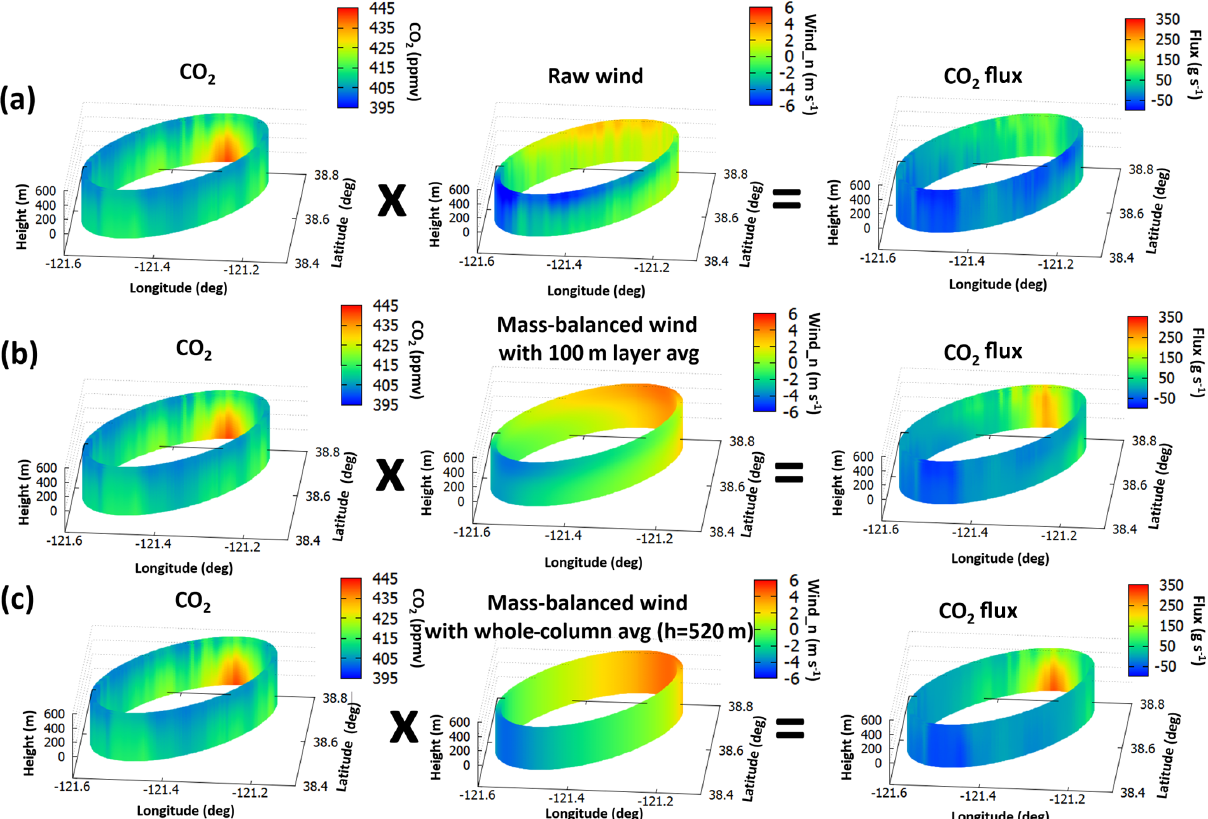
Figure 6. (a) Kriged CO 2 mixing ratio, the raw wind, and CO 2 flux using the raw wind; (b) kriged CO 2 mixing ratio, 100m vertically averaged mass-balanced wind, and CO 2 flux using the mass-balanced wind; and (c) kriged CO 2 mixing ratio, the whole-column-averaged mass-balanced wind, and CO 2 flux using the mass-balanced wind on 18 November 2013. In the middle column, the blue color represents the inflow toward (and red outflow from) the cylinder so that it is defined as negative (positive) wind. The background CO 2 was chosen as the minimum mixing ratio at each vertical layer. The whole-column average means the vertical average from the surface to the top of the planetary boundary layer height (PBLH). Figures are only shown below the